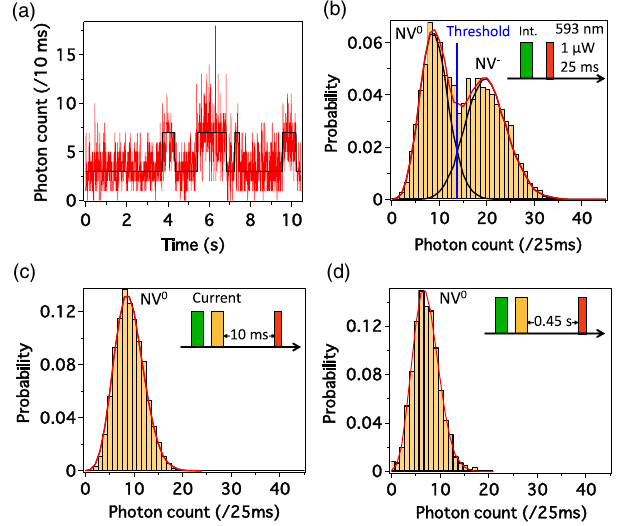
FIG. 4. (a) Time trace of the fluorescence of a single NV under continuous illumination with 593-nm and 1 - μ W laser light, showing the abrupt jumps between the two distinct states of NV: one with high (NV − ) and one with low count rates (NV 0 ). (b) Histogram of photon counts during the 593-nm measurement pulse ( 1 μ W for 25 ms) after illuminating the NV with a 532-nm and 100 - μ W laser light for 20 ms. Two solid black curves are obtained by curve fitting the Poisson distribution. The red solid curve is their sum. The blue line is the threshold that can be used to determine the charge state with one single-shot charge-state measurement. (c) Histogram of photon counts for the 593-nm measurement pulse, after illuminating the NV with a 532-nm and 0.1-mA current injection. The waiting time between the injected current and detection laser pulse (593 nm) is set at 10 ms. (d) Histogram of photon counts with the same pulse sequence as (c), but the waiting time is set at 0.45 s. In Figs. 4(b) – 4(d), we repeated the single-shot charge-state measurements 2,000 times to compile the